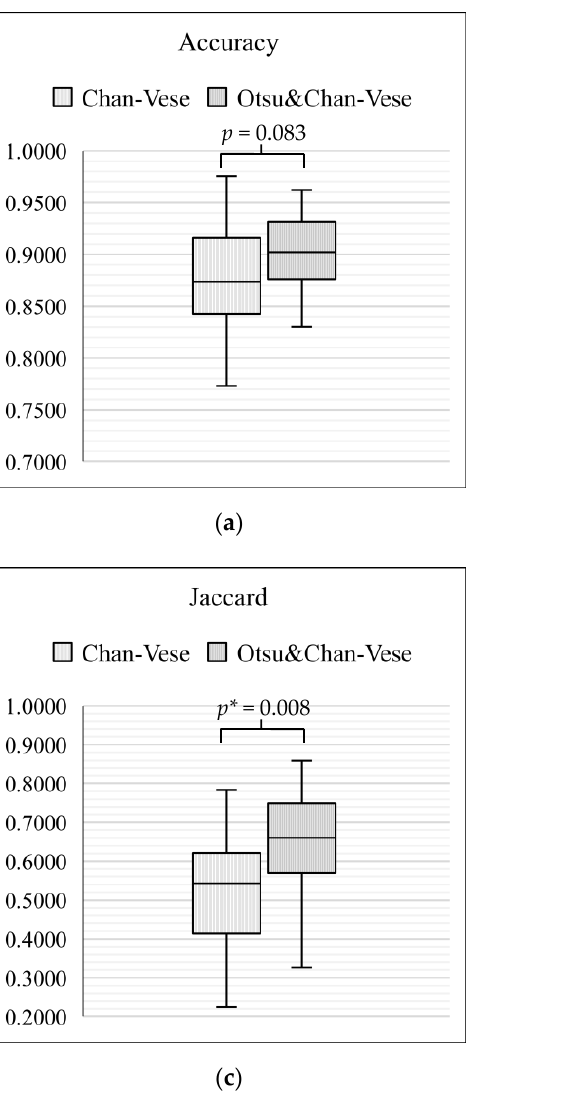
Figure 15. Box-and-whisker plot comparison between the classical Chan – Vese and Otsu’s thresholding with the Chan – Vese method. ( a ) Box-and-whisker plot for accuracy; ( b ) box-and-whisker plot for Dice Score; ( c ) box-and-whisker plot for Jaccard value; ( d ) box-and-whisker plot for sensitivity. * means p -value with the less than 0.05.